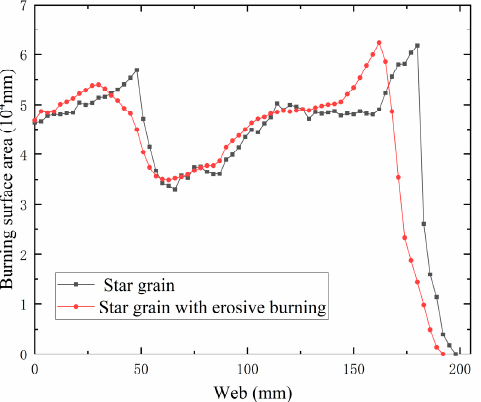
Figure 12. The burning process of star grain under erosive burning.